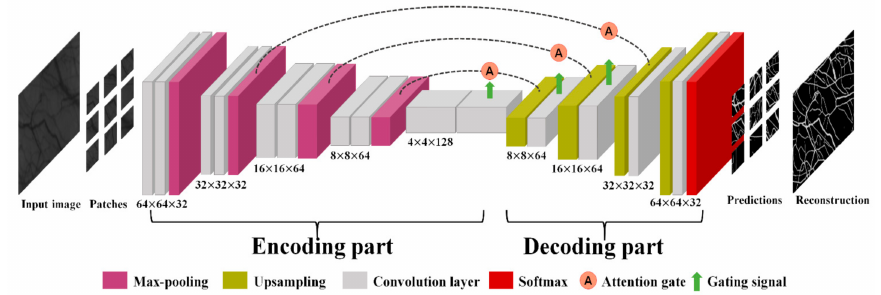
Figure 4. Customized Attention-UNet